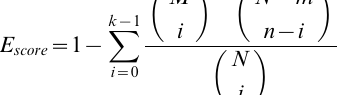
KTT/M/2 on toxin versus Canton-S (group 3 versus 1), and Ama-KTT/M/2 on toxin versus Ama-KTT/M/2 on no toxin (group 3 versus 2). This table contains 4209 DEGs that are differentially expressed in at least one of the three comparisons. Table S2 Complete single gene analysis for Ama-KTT/M/2 versus Canton-S on no toxin (group 2 versus 1). This table contains well-annotated genes that are at least 2.0-fold constitu- tively up-regulated in the resistant stock, as compared to the sensitive stock, on no toxin. The p-value cutoff is p , 0.05. Table S3 Complete single gene analysis for Ama-KTT/M/2 on toxin versus Ama-KTT/M/2 on no toxin (group 3 versus 2). This table contains well-annotated genes that are at least 2.0-fold inducible by feeding larvae of the resistant stock with a -amanitin- containing food, as compared to resistant larvae on no toxin. The p-value cutoff is p , 0.05. Table S4 Genome enrichment analysis for group 2 versus 1 and group 3 versus 2. This table shows the genes behind the peaks in Figure 3. The peak at band 38B is the only locus that is differentially expressed between Ama-KTT/M/2 and Canton-S on no toxin (group 2 versus group 1). The remaining peaks 66A, 69A, 92A, and 96D show differentially expressed loci in response to a -amanitin treatment (group 3 versus group 2). All p-values are corrected and fold-changes are given for the individual genes. Peaks 66A and 96D are very close to the two QTL mapping peaks identified in previous studies [14,15]. Table S5 Comparison of qPCR and microarray fold-induction values. The first five genes were constitutively over-expressed in Ama-KTT/M/2, as Compared to Canton-S (Group 2 versus group 1). The last five genes were induced by a -amanitin in Ama- KTT/M/2, as compared to Ama-KTT/M/2 on no toxin (group 3 versus group 2). The RT-qPCR p-values are uncorrected, while the array p-values are